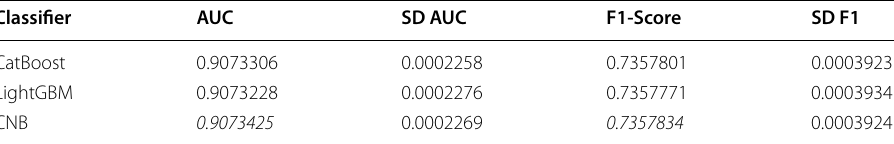
Best metrics are highlighted in italics; SD AUC is the standard deviation of AUC and SD F1 is the standard deviation of the